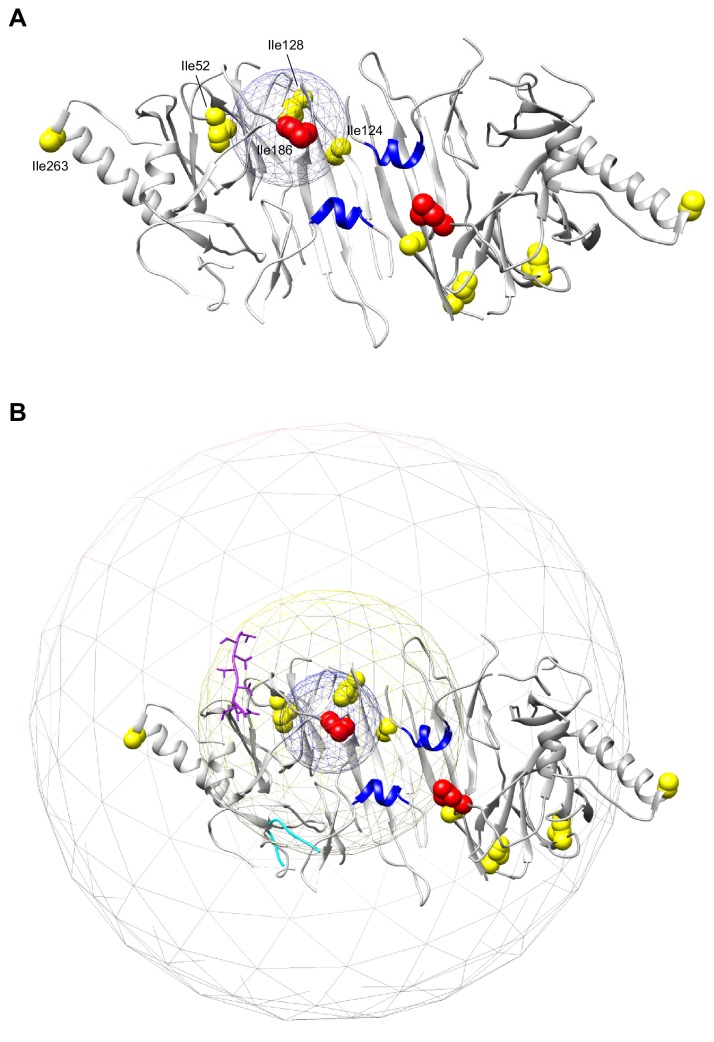
Implications of the distance constraint arising from the paramagnetic relaxation enhancement (PRE) experiments with IRE1LD and an MPZ-proxyl-labelled peptide (Karagöz et al., 2017) to the possible modes of peptide binding.(A) Cartoon representation of the IRE1LD dimer with protomers in light and dark grey (PDB: 2HZ6). The two helices flanking the MHC-like groove are coloured in blue. The isoleucines (Ile) whose peaks were suppressed or broadened upon introduction of the spin-labeled MPZ peptide are highlighted in red and yellow, respectively (from Figure 5 in Karagöz et al., 2017, doi.org/10.7554/eLife.30700.016). The incorporated spin label causes broadening of Ile peaks in a range of 10 to 25 Å or entirely erases them within distances of <10 Å (Gottstein et al., 2012). Therefore, the broadening of peaks observed in the NMR spectra of IRE1LD serves as a distance constraint, positioning the labelled residue of the MPZ peptide within 10 Å of Ile186 (in red). The blue mesh of 10 Å diameter centred on Ile186 depicts the distance constrain on the proxyl-labelled Cys5 of the MPZ peptide (LIRYCWLRRQAALQRRISAME). (B). As in ‘A’, but with two extra spheres centred at Ile186 with diameters of 26 Å (yellow meshes) and 58 Å (grey meshes) to show the possible location of the MPZ peptide in either helical or extended conformation, respectively. Also shown is the 8-residues-long peptide (magenta) present in the yeast IRE1LD crystal structure (Credle et al., 2005, PDB: 2BE1, superimposed onto the human model) and a superimposed peptide (cyan) found in the PERKLD structure (Wang et al., 2018, PDB: 5V1D). Note: There are 16 residues between Cys5 and the C-terminus of the MPZ peptide. If extended, the peptide is free to sample a sphere with a radius of ~48 Å from Cys5. Given that the PRE experiments place Cys5 of the peptide anywhere within 10 Å of IRE1LD Ile186, if extended, the peptide is free to explore the entire space encompassed by the grey mesh. Even if constrained to assume a compressed helical conformation, the peptide could be found anywhere within the yellow mesh. The numerous perturbations to the NMR spectrum arising from the presence of unlabelled peptide may reflect either the consequences of a peptide-IRE1LD interaction or an induced conformational change in the IRE1LD (as noted by Karagöz et al., 2017). Therefore, they do not constrain the location of the peptide. Constraint is provided by the PRE experiments, noted above, but these are not incompatible with the peptide binding outside the MHC-like groove.